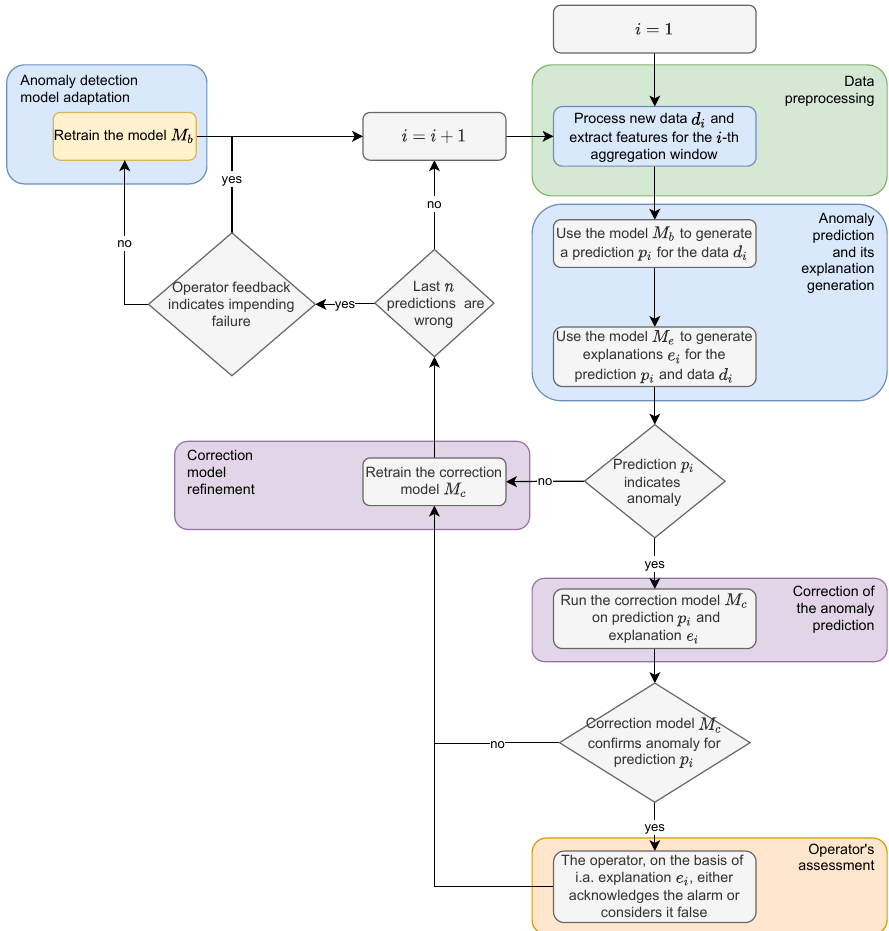
Figure 1. Diagram of the main phase of the proposed